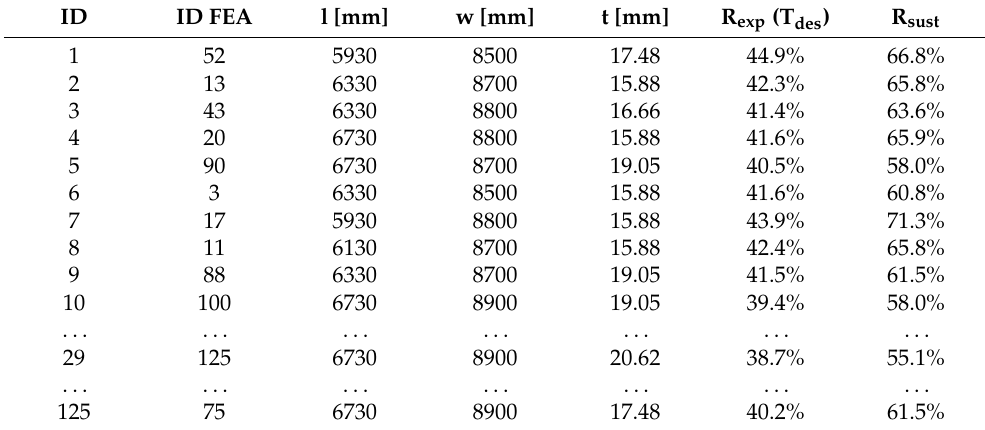
Table 2. Factorial design and FEA